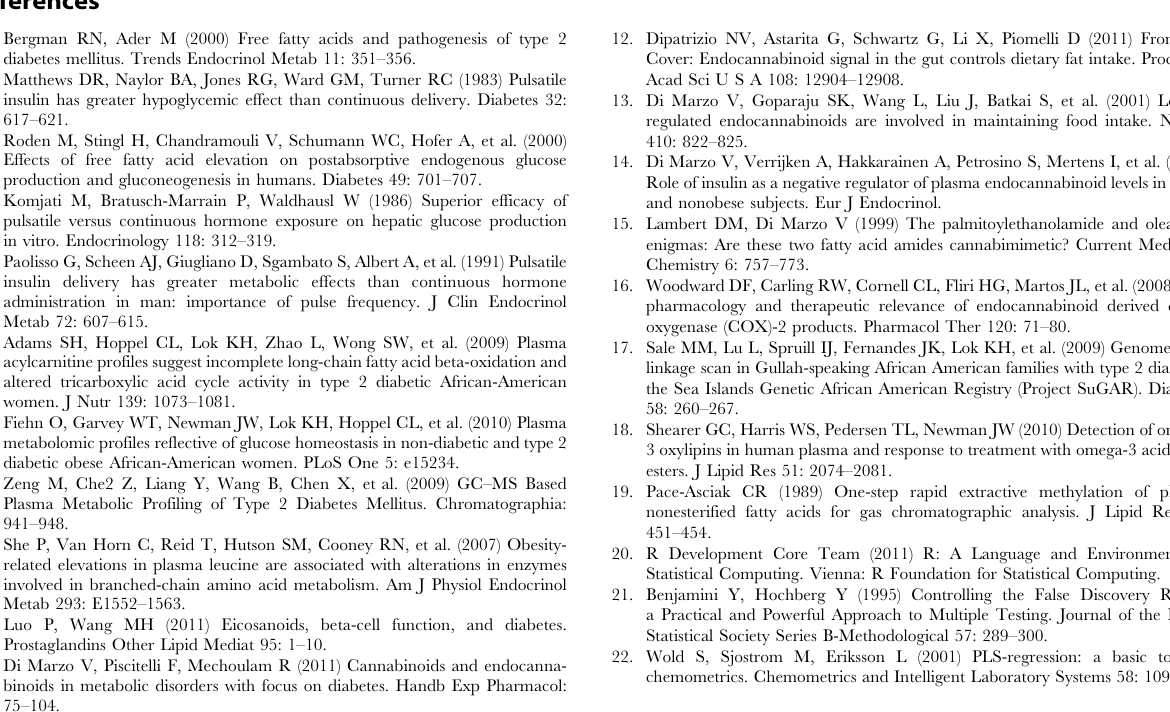
Table S6 Plasma eighteen carbon oxylipins (nM) in obese African-American women. Geometric mean and ranges are listed for all measured metabolites in this class for experimental groups with and without Type 2 diabetes. Table S7 Plasma twenty and twenty-two carbon oxyli- pins (nM) in obese African-American women. Geometric mean and ranges are listed for all measured metabolites in this class for experimental groups with and without Type 2 diabetes. Table S8 Plasma N-acylethanolamides (nM), lipoamino acids (nM) and monoacylglycerols ( m M) in obese Afri- can-American women. Geometric mean and ranges are listed for all measured metabolites in this class for experimental groups with and without Type 2